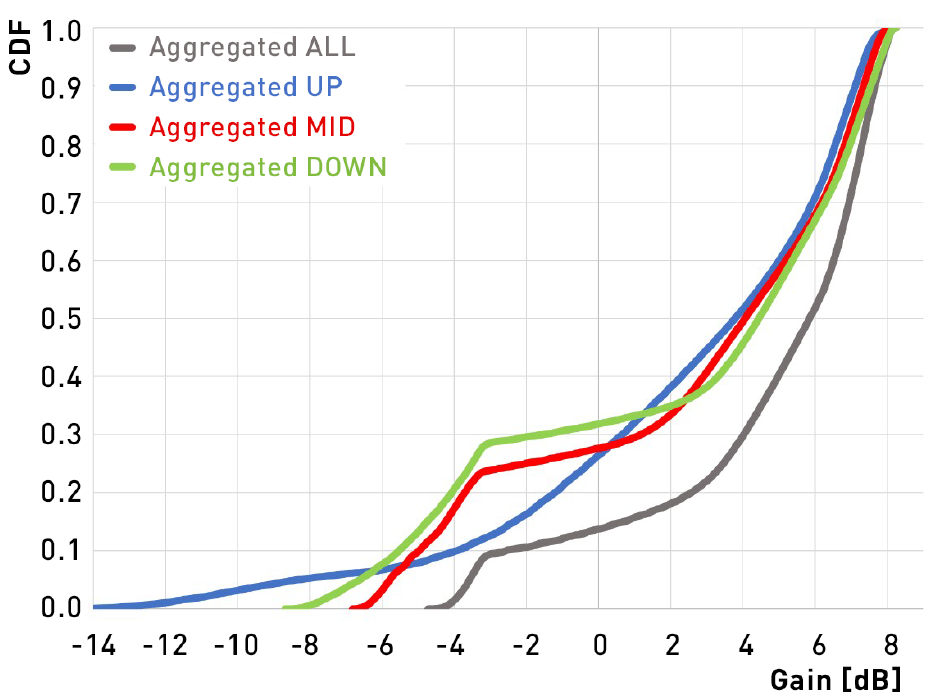
Figure 9. Cumulative Distribution Function of the aggregated gain for different sets of characteris-